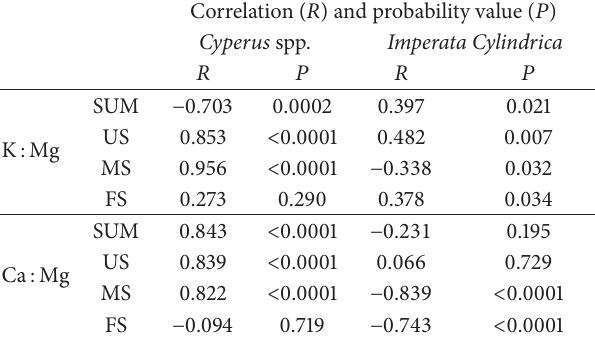
Table 4: Pearson correlation values ( 𝑅 ) and its probabilities ( 𝑃 ) between Cyperus spp. and Imperata Cylindrica and soil different ratios in K:Mg and Ca: Mg at each topographic position. Correlation ( 𝑅 ) and probability value ( 𝑃 ) Cyperus